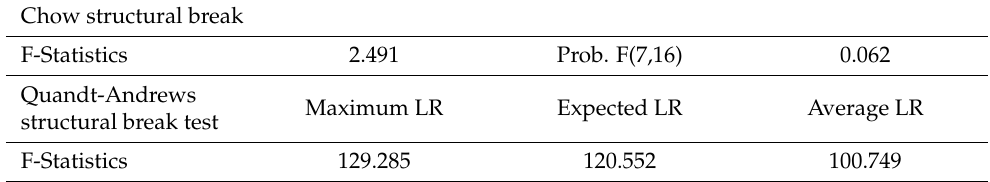
Table 3. Structural break test.